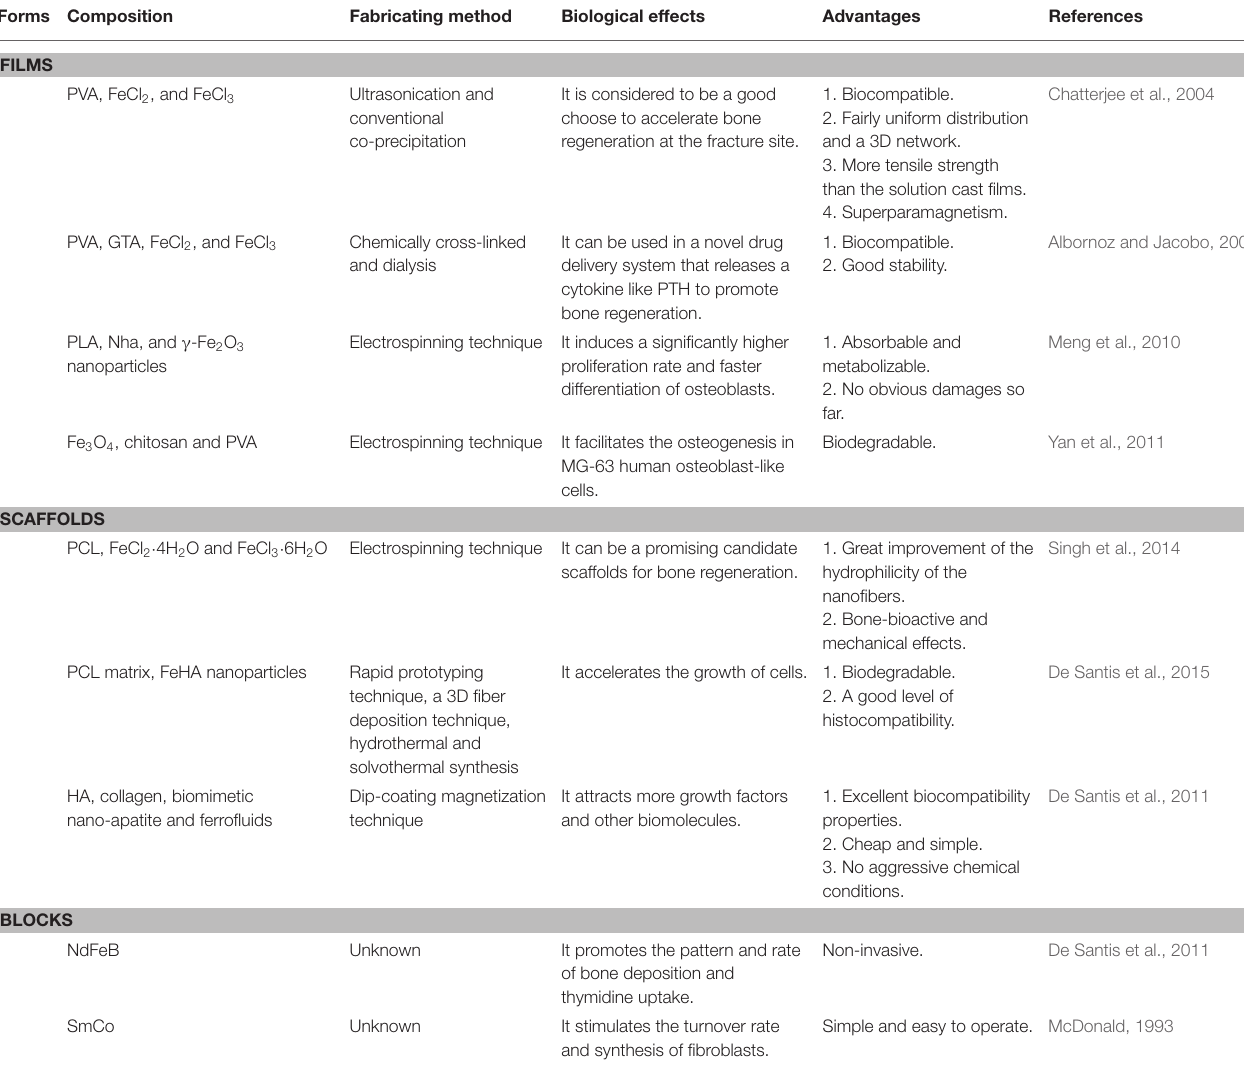
TABLE 5 | Comparison of three common forms of magnetic materials used in bone